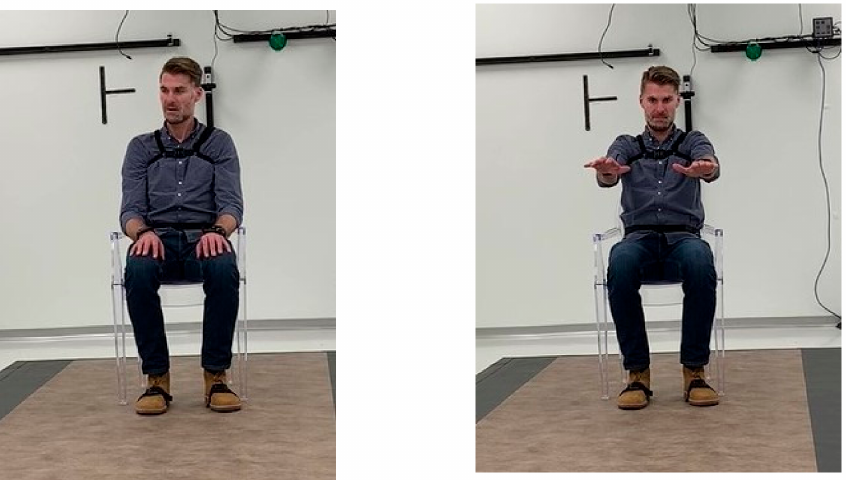
Figure 2. Illustration of WATCH-PD digital sensor instrumentation during defined motor examina- tion test as demonstrated by co-author JC.